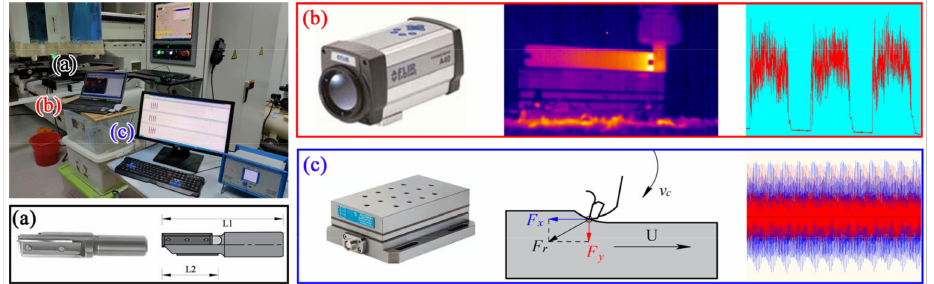
Figure 1. Milling experiment: ( a ) cutting tool, ( b ) cutting temperature measurement, ( c ) cutting force measurement.